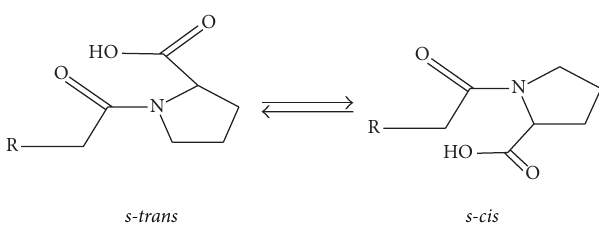
Figure 1: Interconversion of